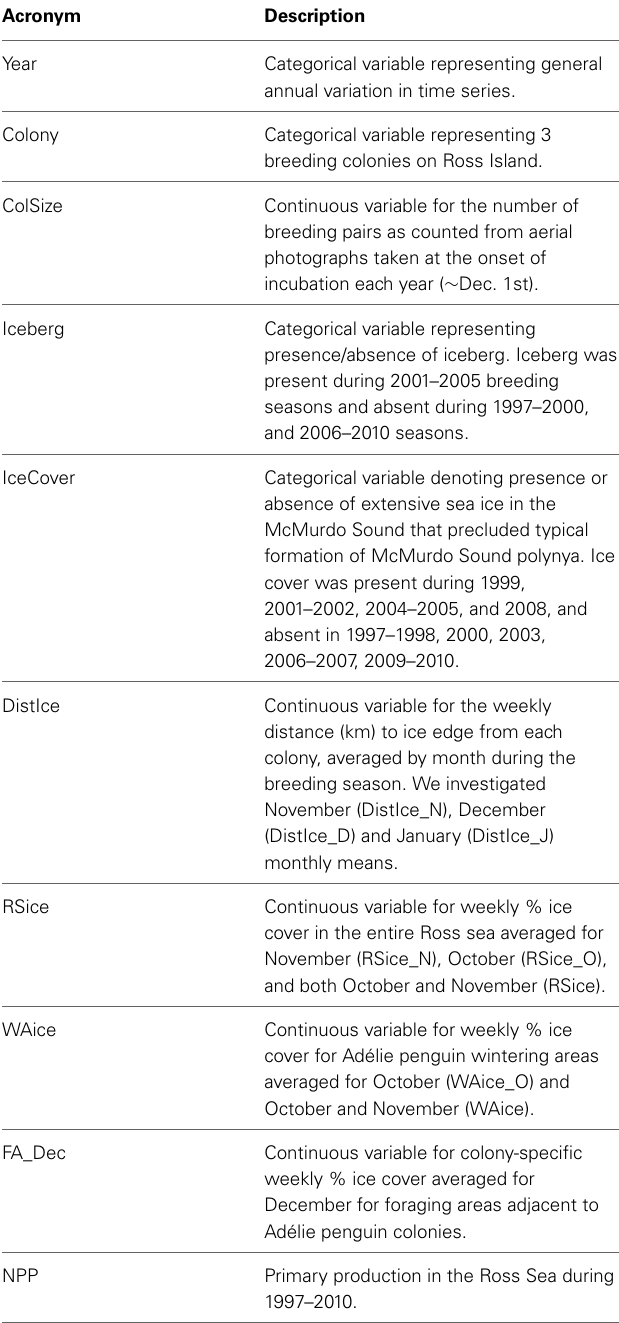
Table 1 | Acronyms and brief descriptions of environmental covariates used to model relative peak hatch date, annual productivity (chicks per pair), and mean chick mass at 5 weeks post-hatch for Adélie penguins breeding at Cape Royds, Cape Bird and Cape Crozier on Ross Island during